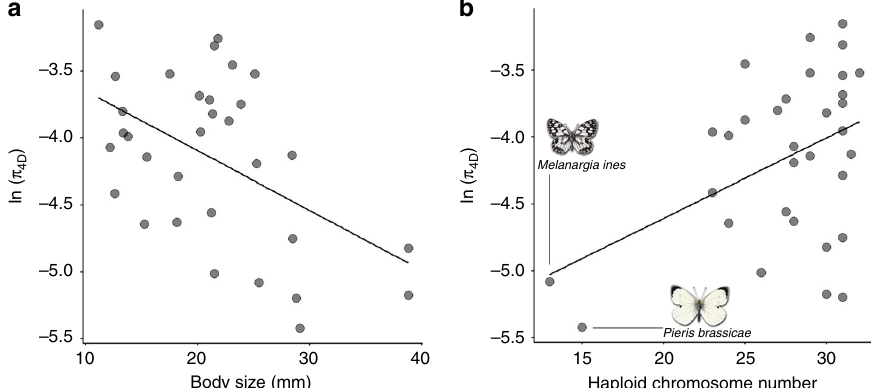
Fig. 2 The correlates of genetic diversity in butter fl ies. Neutral genetic diversity π 4 D ( a ) is negatively correlated with body size and positively with the number of chromosomes ( b ). Source data are provided as a Source Data